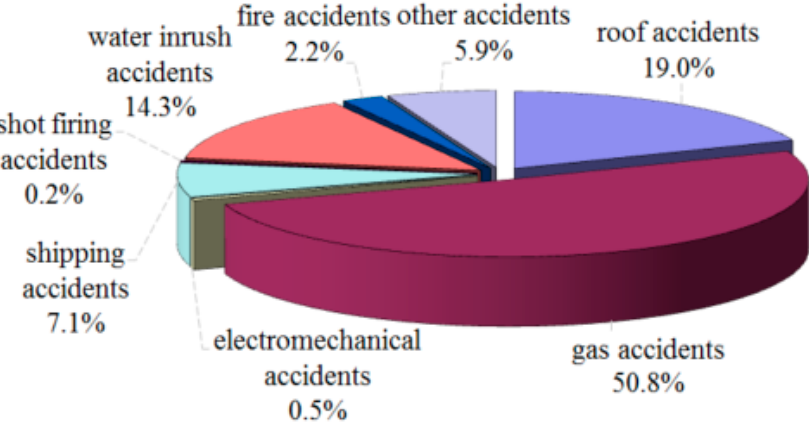
Figure 1. The proportion of larger accidents in coal mining in China in 2012.